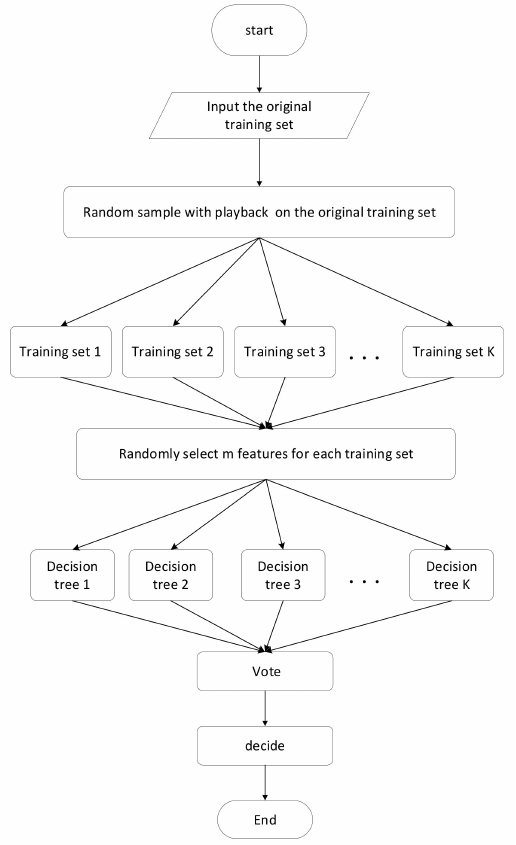
Figure 1. Flow chart of Random